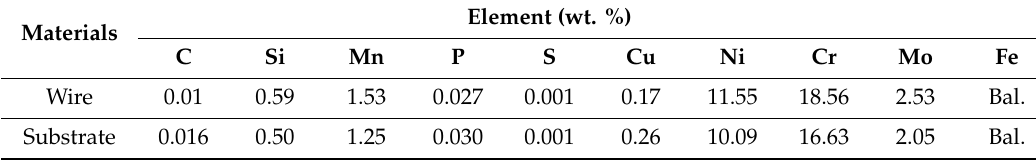
Figure 1. Schematic of the experimental setup. Table 1. Chemical compositions of the STS 316L wire and substrate.